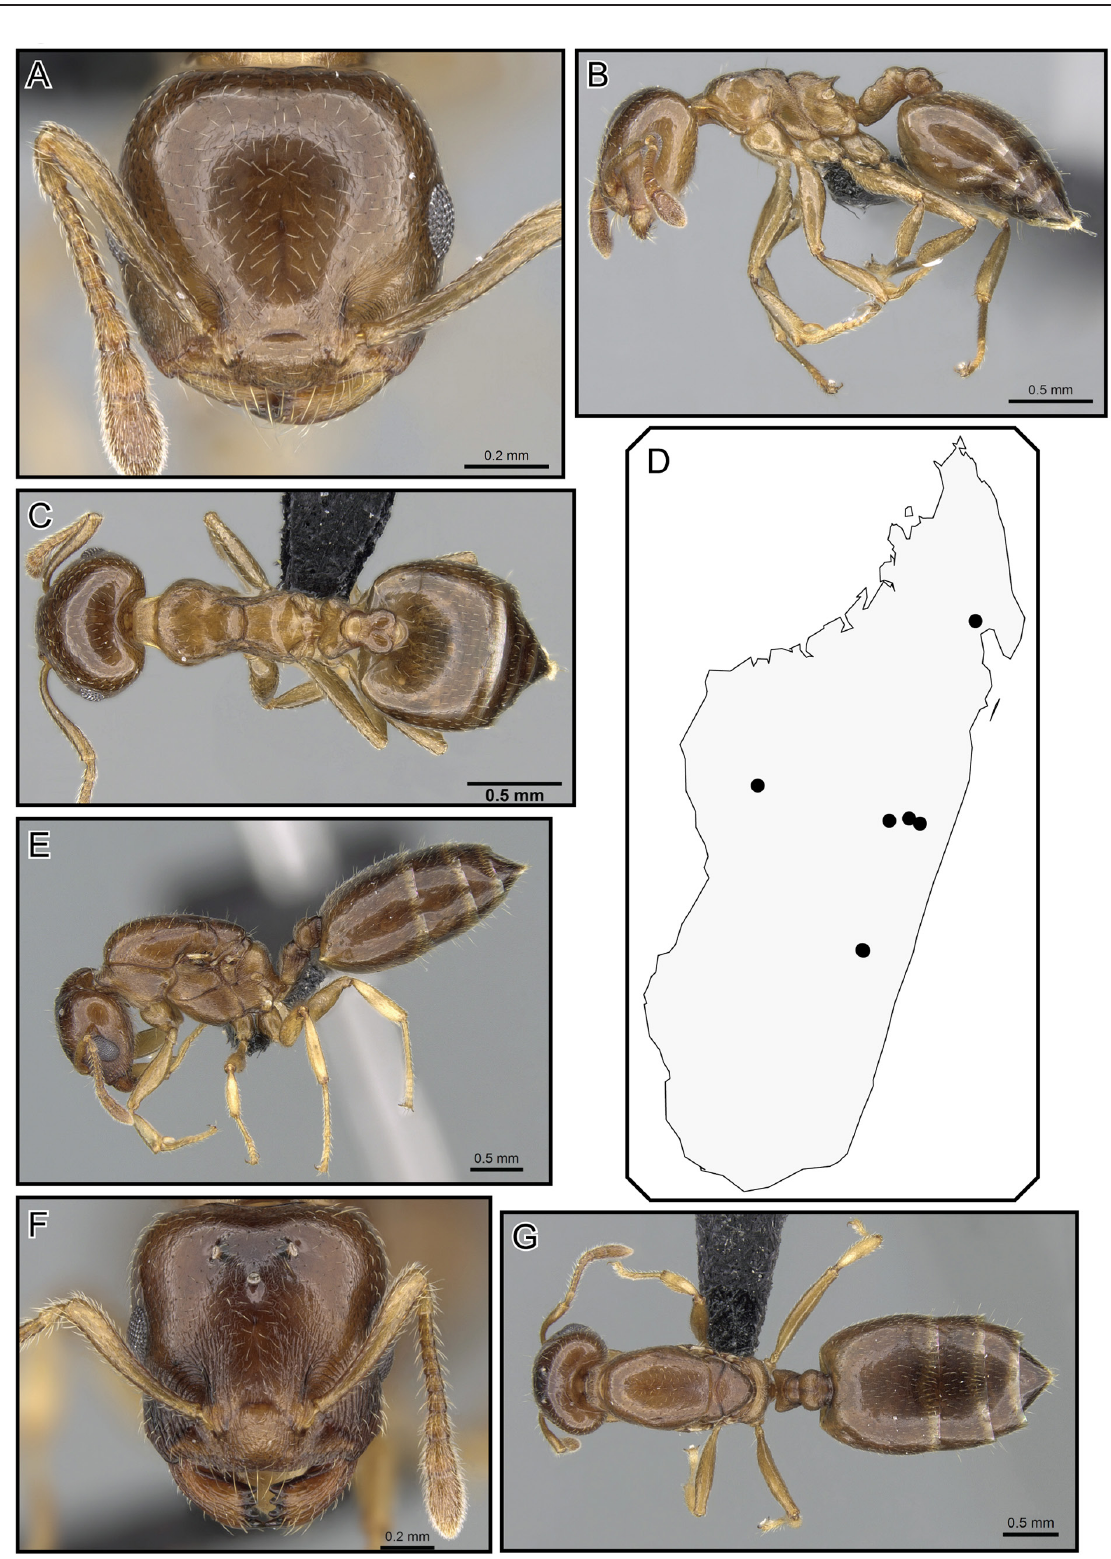
Fig. 6. Crematogaster alafara sp. nov., worker, queen and distribution. A-C. Worker (CASENT0492837). A. Full-face. B. Profile. C. Dorsal. D. Species distribution. E-G. Queen (CASENT0050441). E. Profile. F. Full-face. G.